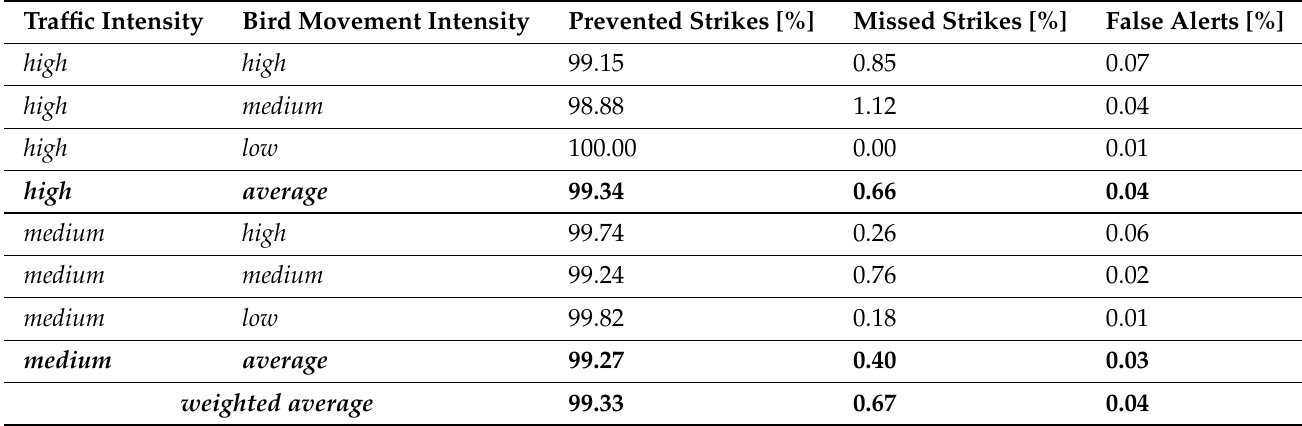
Table 2. Analyzed strike parameters for all scenarios, averaged per air traffic intensity as well as averages weighted by number of flights over all